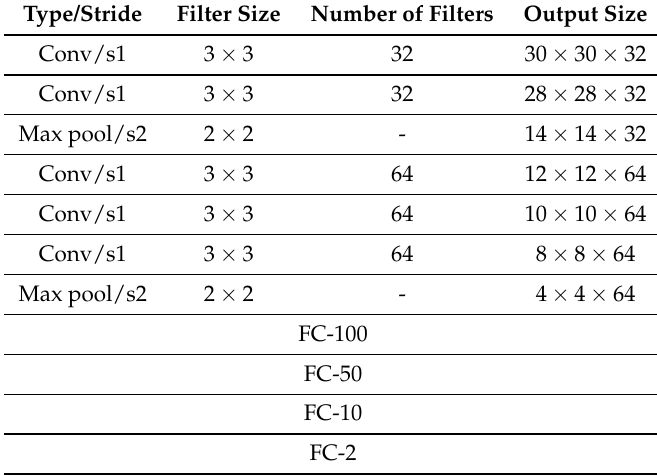
Table 2. The CNN architecture for finding the ( x , y ) coordinates of the center of a kernel image. The Conv and FC stand for convolutional layer and fully connected layer,